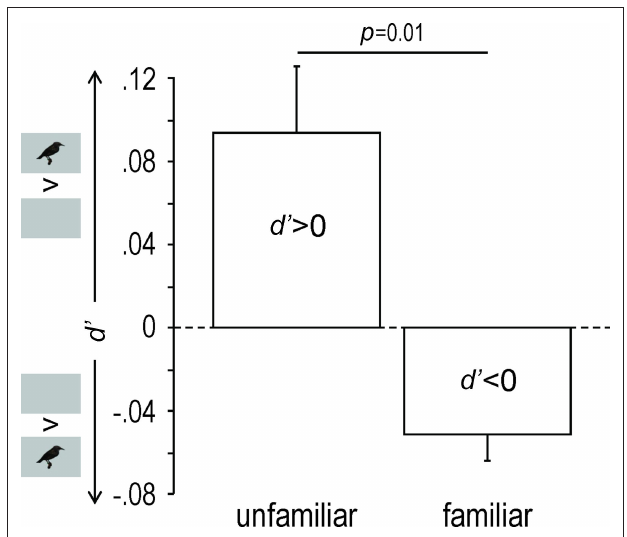
FigurE 5 | response magnitude as shown by mean ( + SEM) Z -scores values obtained across birds for unfamiliar and familiar stimuli. Only neuronal sites exhibiting a | d ′ | value of 1 or more were taken into account. Small inserts under the bars indicate whether the acoustic stimuli were presented with (AV condition) or without (A condition) visual